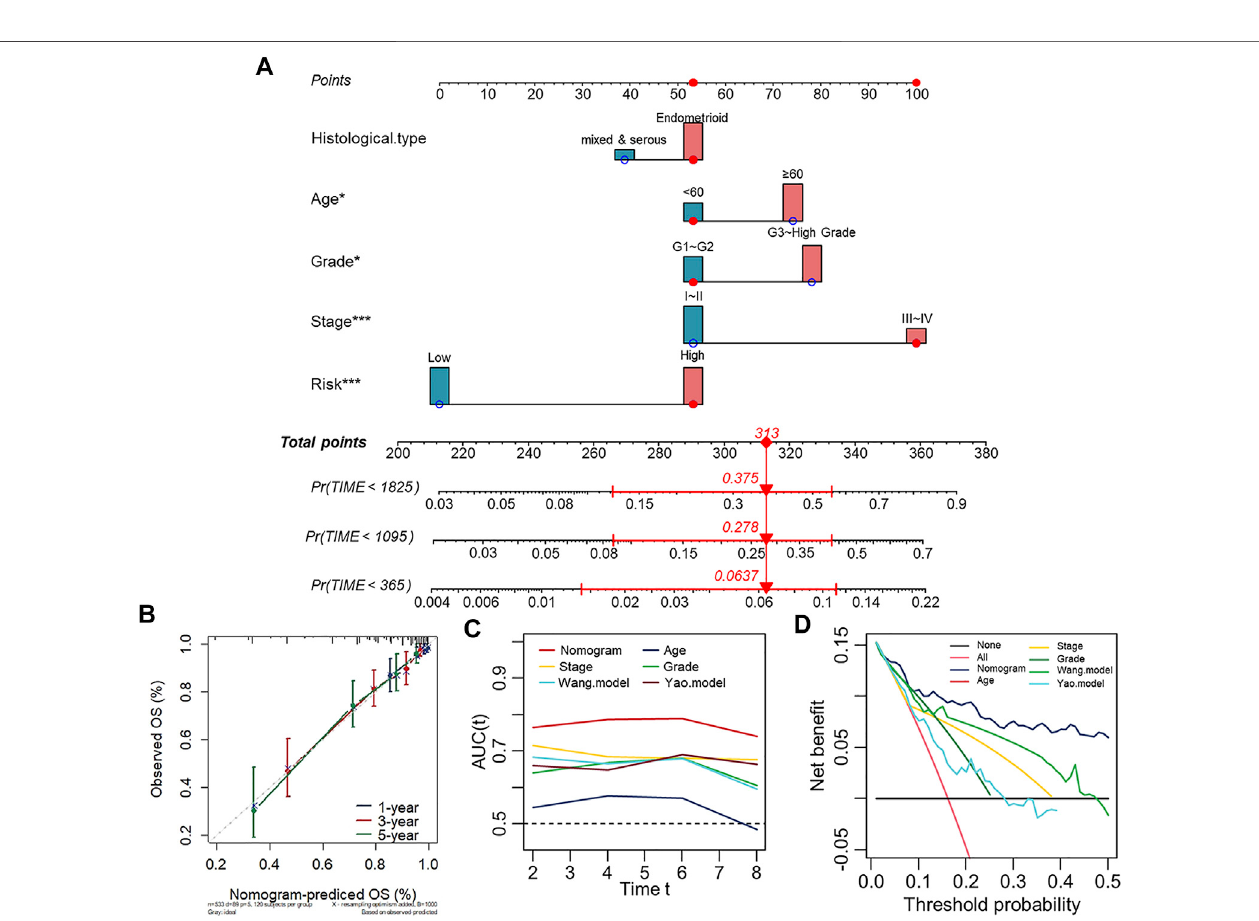
FIGURE 5 | Establishment of the prognostic nomogram for the survival of patients with UCEC. (A) Nomogram for predicting the 1/3/5-years overall survival of patientswithUCEC. (B) Calibrationcurveforthepredictionof1/3/5-yearsoverallsurvival. (C) Acomparisonoftime-dependentAUCcurveswithotherclinicopathological features showing the powerful capacity for survival prediction of the nomogram. (D) Decision curves for 5-years OS in the Entire set.